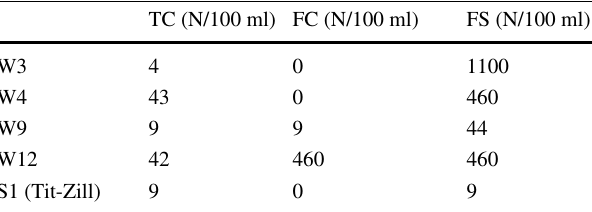
Table 5 Results of bacteriological analyses of